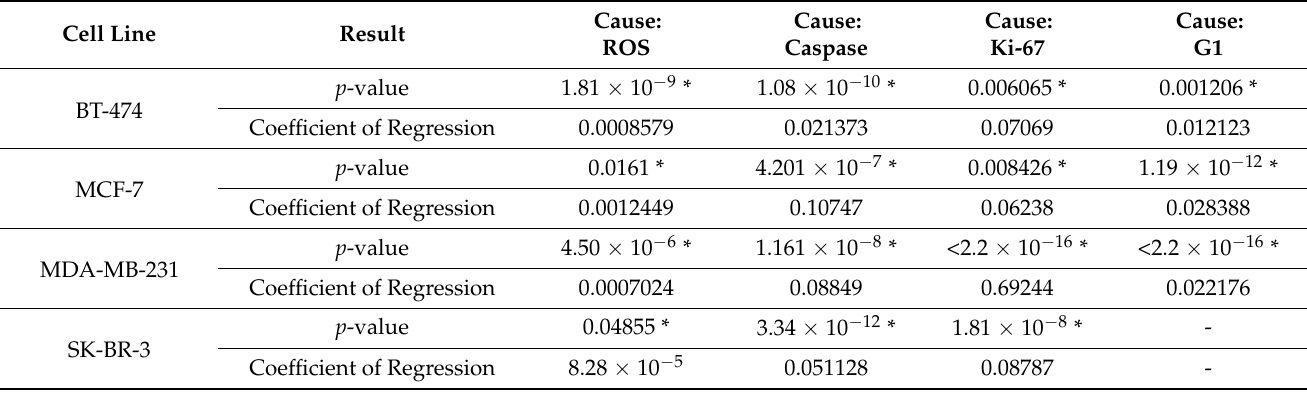
Table 3. p -values and coefficients of linear regression for all cell proliferation models for cells treated for 5 min (* p < 0.05).